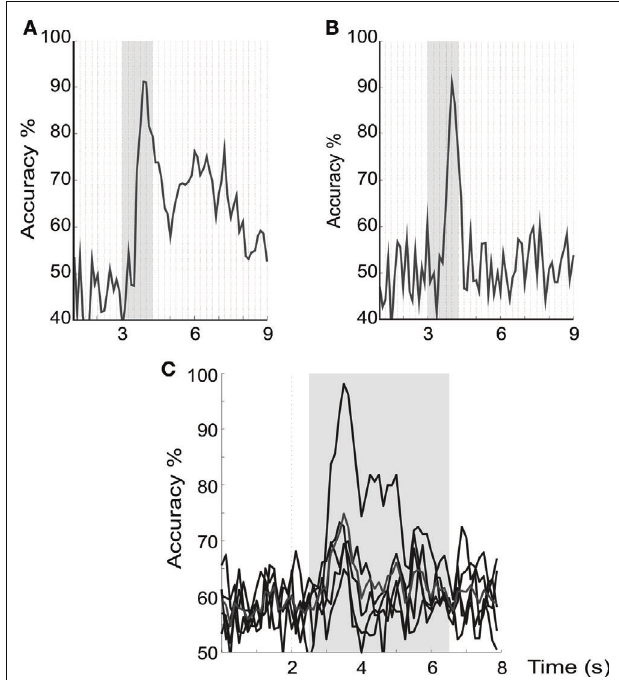
FIGURE 9 | Example of discrimination time courses (off-line classifi cation accuracy) from two different studies with visual cue-based right and left hand motor imagery. In one study (Pfurtscheller et al., 2008c) subjects with BCI experience took part, whereas the other study used naïve subjects (for details see “Simultaneous ERD/SSVEP BCI to Improve Accuracy”; Allison et al., 2010). (A,B ) Display the discrimination accuracy of two subjects from the group of BCI experienced subjects, and (C) displays superimposed accuracy time courses of fi ve subjects of the naïve group. In all examples an early discrimination peak ∼ 1 s after visual cue onset is visible. Cue duration is indicated by the grey